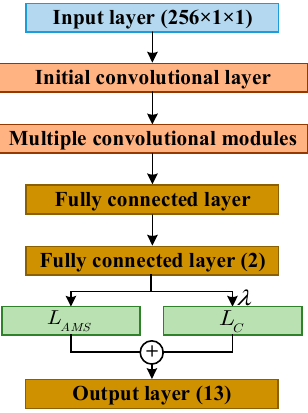
Figure 4. The structure of the presented model.